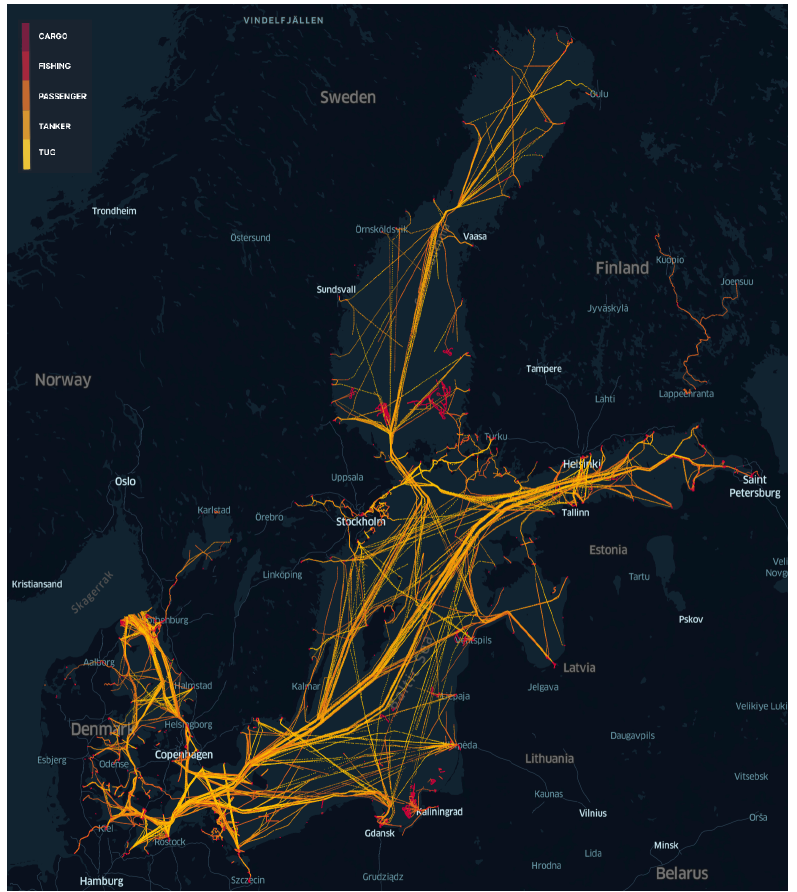
Figure 1. A visualization of AIS data related to the Baltic Sea on 1 June